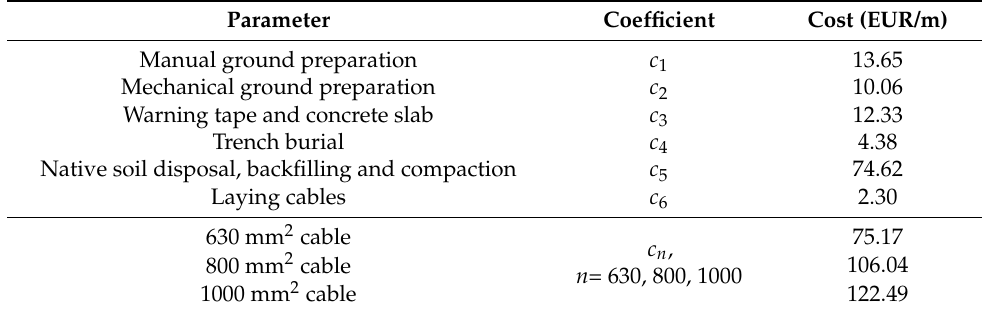
Table 1. Unit costs of the individual elements for the analyzed cable